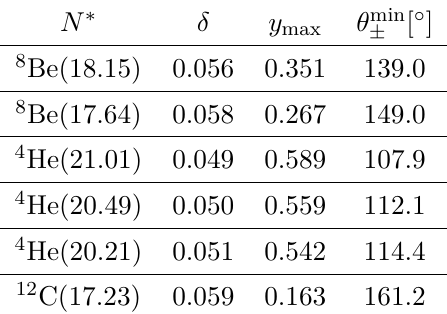
Table 7 . δ parameter, maximum energy asymmetry y max and minimal opening angle θ min hypothetical boson of mass m